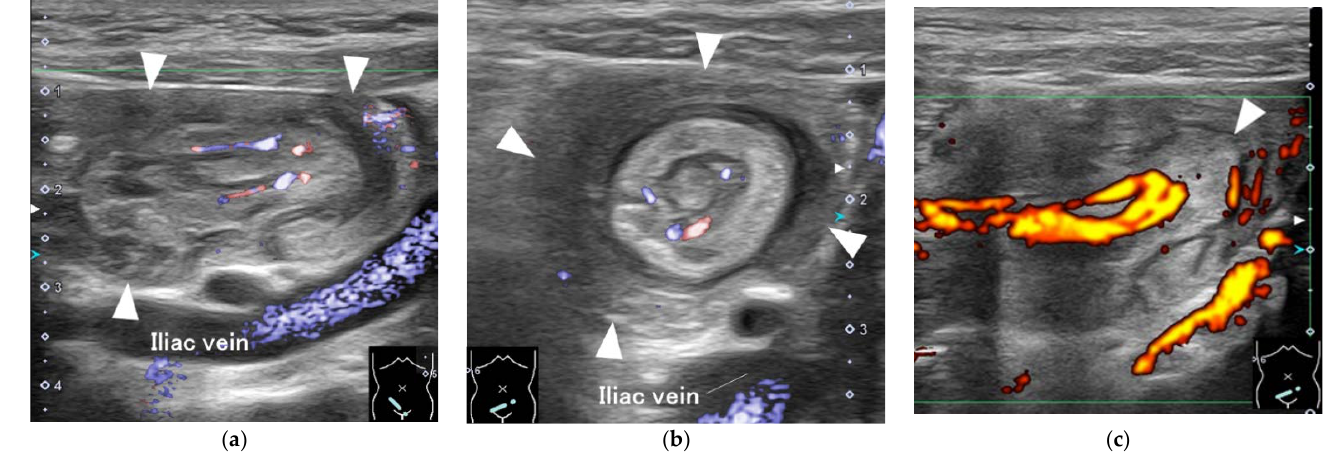
Figure 1. Ultrasonography findings at admission. ( a ) Pseudokidney sign in the lower abdominal long axis image (advanced dynamic flow); ( b ) Multiple concentric ring signs in the lower abdominal short axis image (advanced dynamic flow); ( c ) Increased blood flow signal towards the mass lesions (arrowhead) at the tip of the inner tube (power Doppler image).